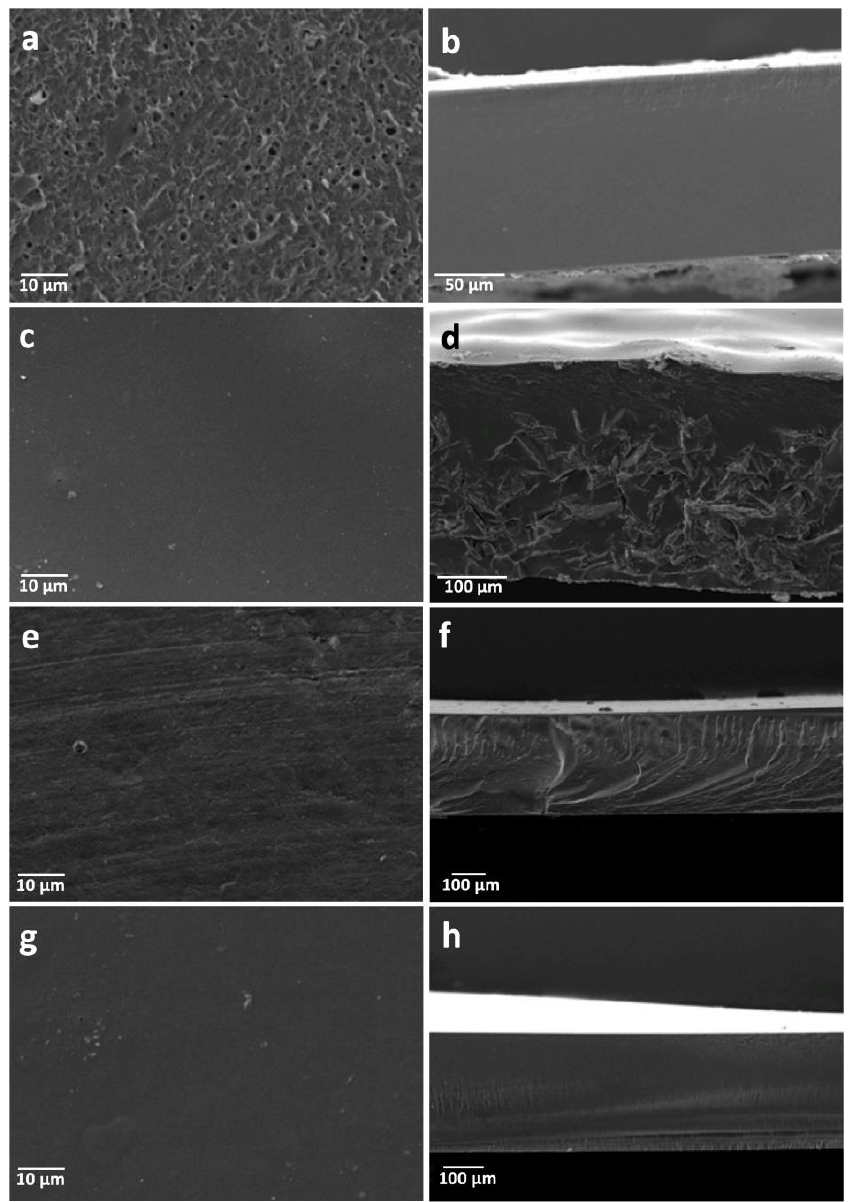
Figure 4. SEM micrographics from the surface and side view of PDCAH. ( a – b ) PMALEH; ( c – d ) PAAH; ( e – f ) PSAH; ( g – h )